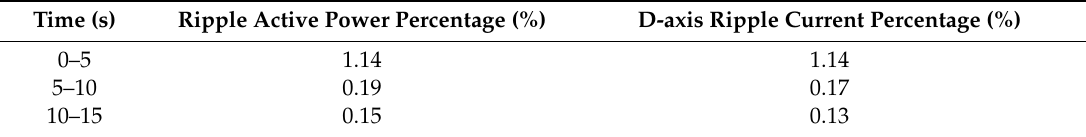
Table 4. Ripple component of grid connection point ripple after suppression.